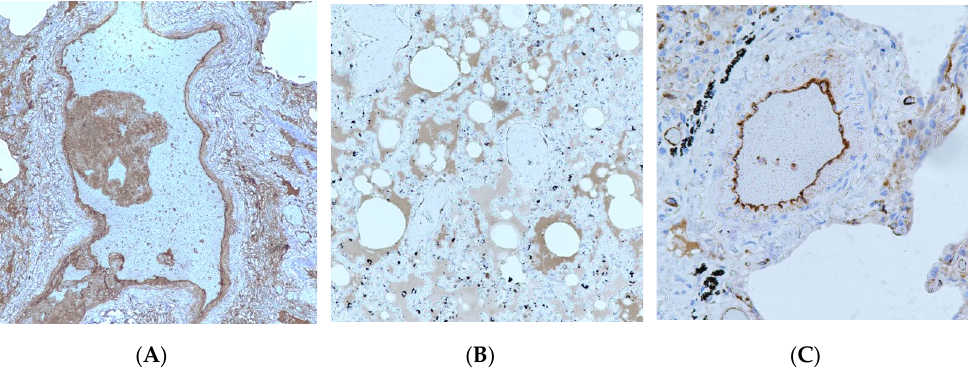
Figure 3. Positive VWF immunostaining: ( A ) in the mural thrombus, ×100 magnification; ( B ) in the edematous fluid in the alveoli, ×200 magnification; ( C ) in the pulmonary vascular endothelium, ×400 magnification.